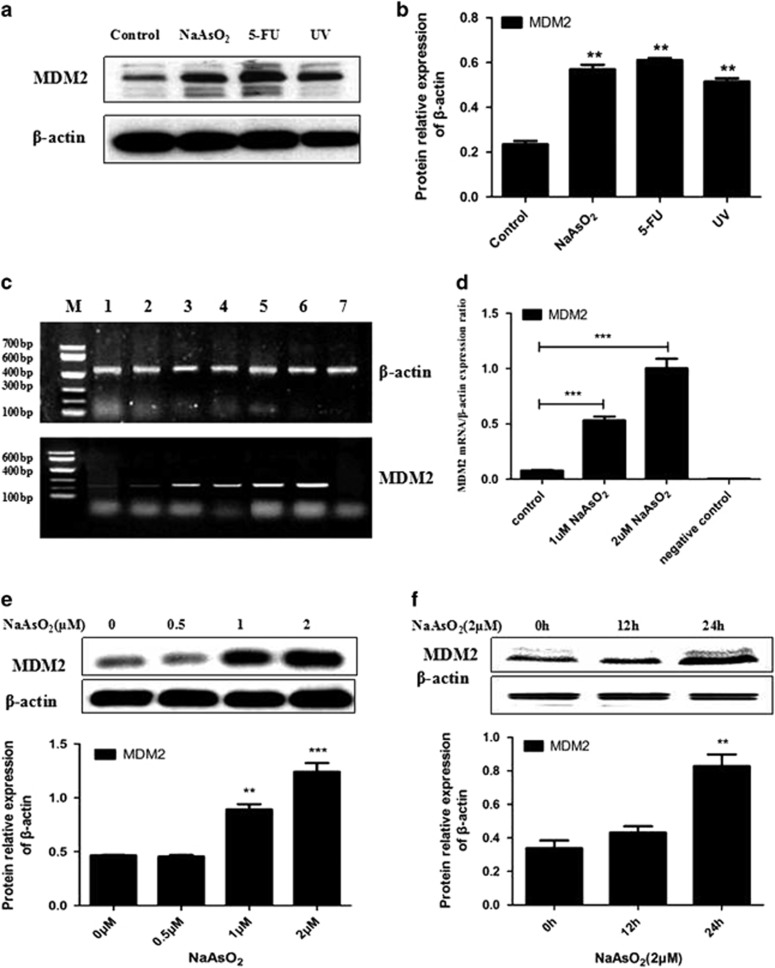
Expression of MDM2 and MDM2 mRNA. (a) In cells treated with sodium arsenite, the MDM2 expression was increased. When cells were treated with UV radiation or 5-FU also, the MDM2 expression was increased. (b) Histograms show the relative fold change of proteins (mean±s.e.m. of triplicates) using β-actin as the control of protein loading. *P<0.05 vs Control. (c) MDM2 mRNA expression was increased after treatment with sodium arsenite. 1–2: control, 3-4: 1 μmol/l NaAsO2 24 h, 5–6: 2 μmol/l NaAsO2 24 h, 7: negative control. (d) MDM2 mRNA relative expression ratio, ***P<0.001 vs Control. (e) The MDM2 expression increased following sodium arsenite exposure in a concentration-dependent manner. **P<0.01, ***P<0.001 vs control. (f) The MDM2 expression increased following sodium arsenite exposure in an exposure time-dependent manner. **P<0.01 vs control.